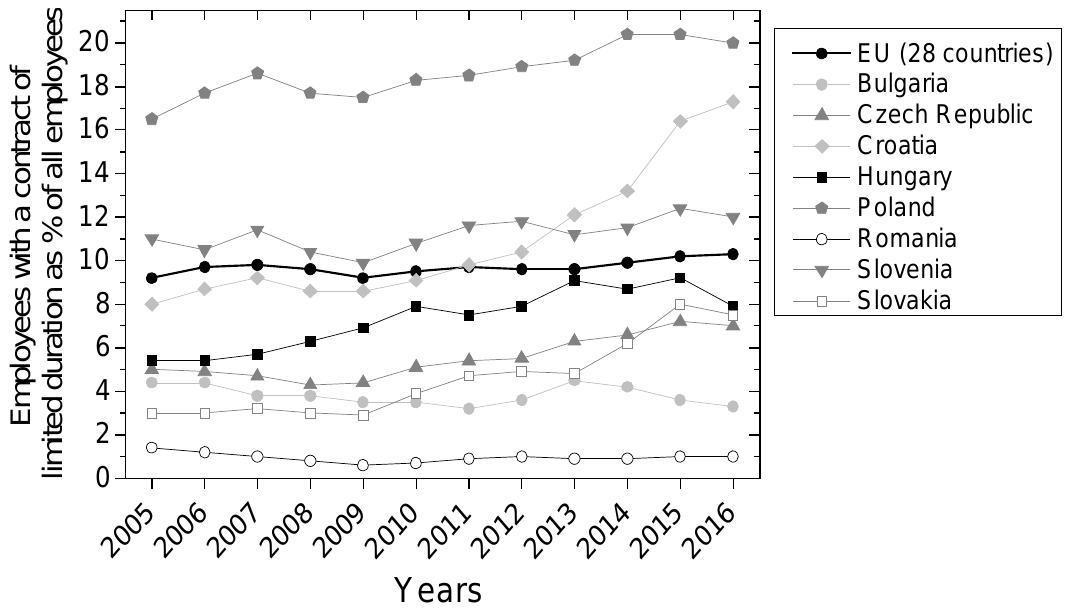
Figure 3. Employees with a contract of limited duration (annual average) as % of total number of employees between 2005–2016 in Central and Eastern Europe. Most countries here have fewer fixed term employment contract than the EU average of about 10%. The about 20% fixed term employment contract in Poland is extreme in the EU, only mirrored by data from Spain. Source: Eurostat http://ec.europa.eu/eurostat/tgm/refreshTableAction.do?tab=table&pcode=tps00073&language=en.